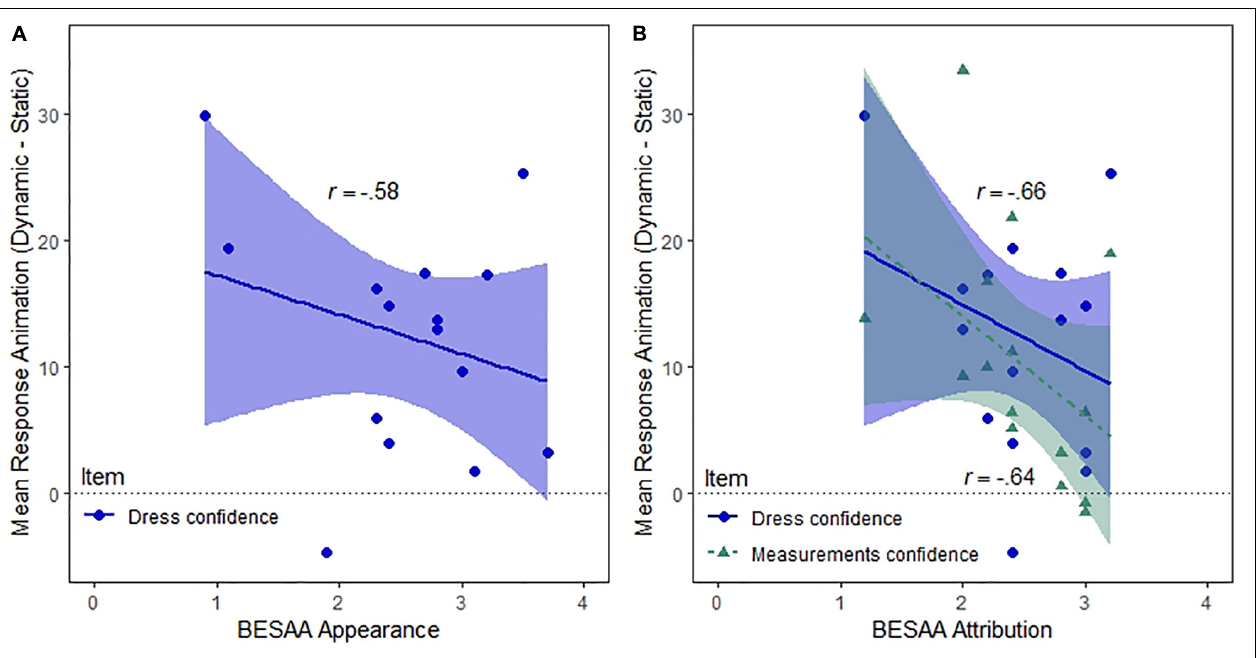
FIGURE 4 | Correlations between the main effect of Animation and the (A) Appearance (general feelings about one’s appearance) and (B) Attribution (evaluations attributed to others about one’s body appearance) subscales of the Body Esteem Scale for Adolescents and Adults (BESAA). Higher scores on the BESAA reflect more positive attitudes. Dress = How likely do you think it is that this dress fits you? , Dress confidence = How certain are you? , Measurements confidence = How certain are you? (In response to How likely do you think it is that this avatar’s measurements correspond to your own?